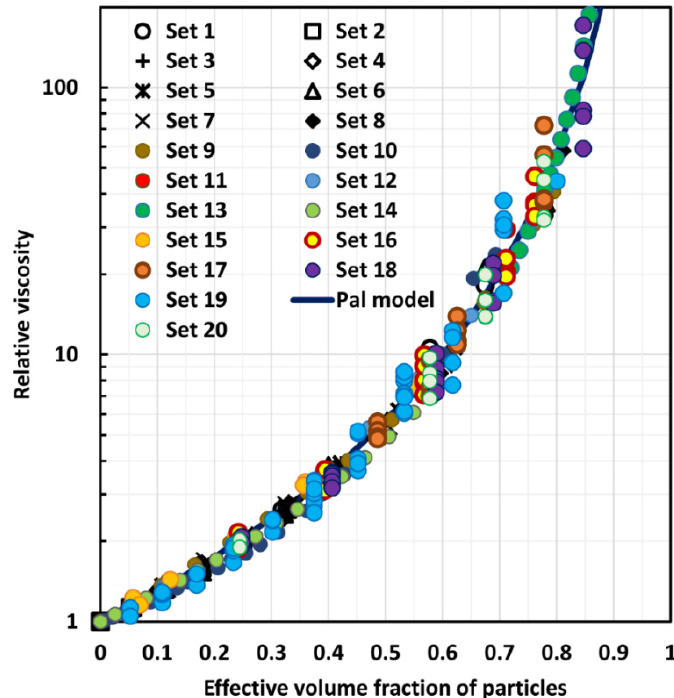
Figure 14. Comparison of experimental viscosity data for suspensions of non-Brownian hard spheres with the prediction of the proposed model, Equation (34) ( φ m varies from one set to another in the range of 0.58 to 0.68). Table 3. Summary of φ m values used in the plotting of Figure 14.